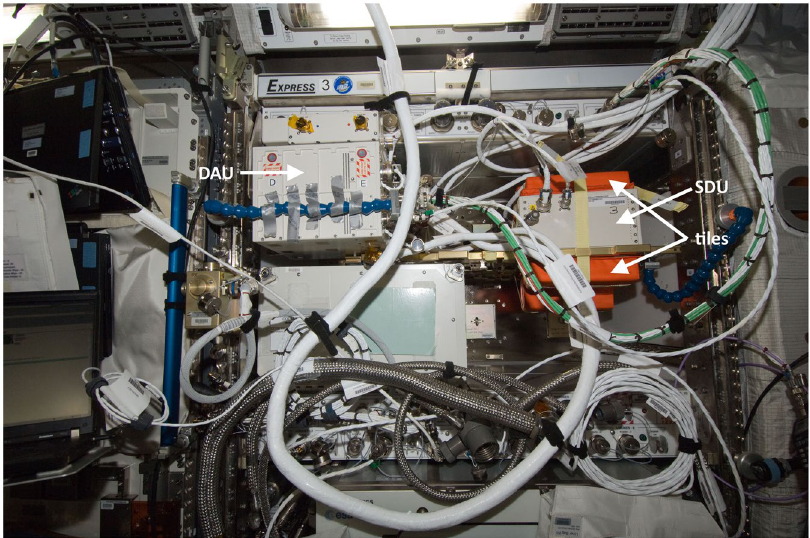
Figure 2. Position of the ALTEA-shield system. The ALTEA system is shown in its measurement location inserted in Express Rack 3 in the Columbus